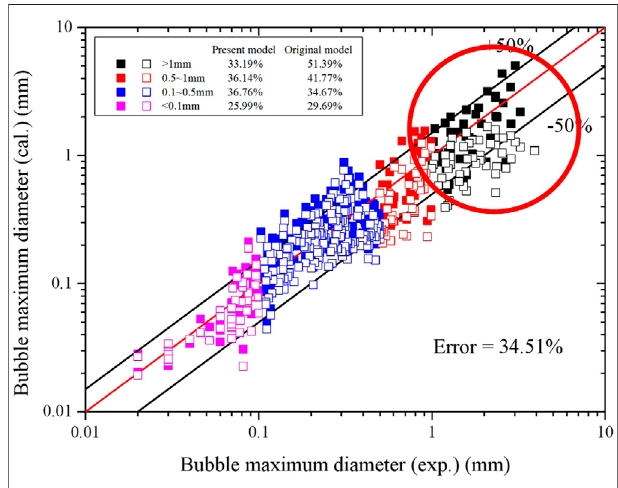
FIGURE 7 | Comparison of new correlation and original model for different bubble sizes.